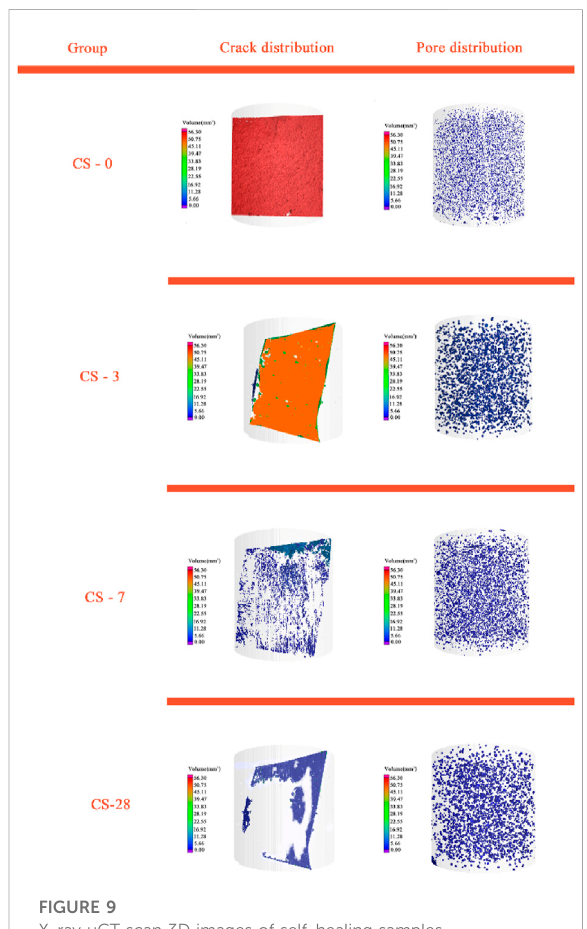
FIGURE 9 X-ray μ CT scan 3D images of self-healing samples.